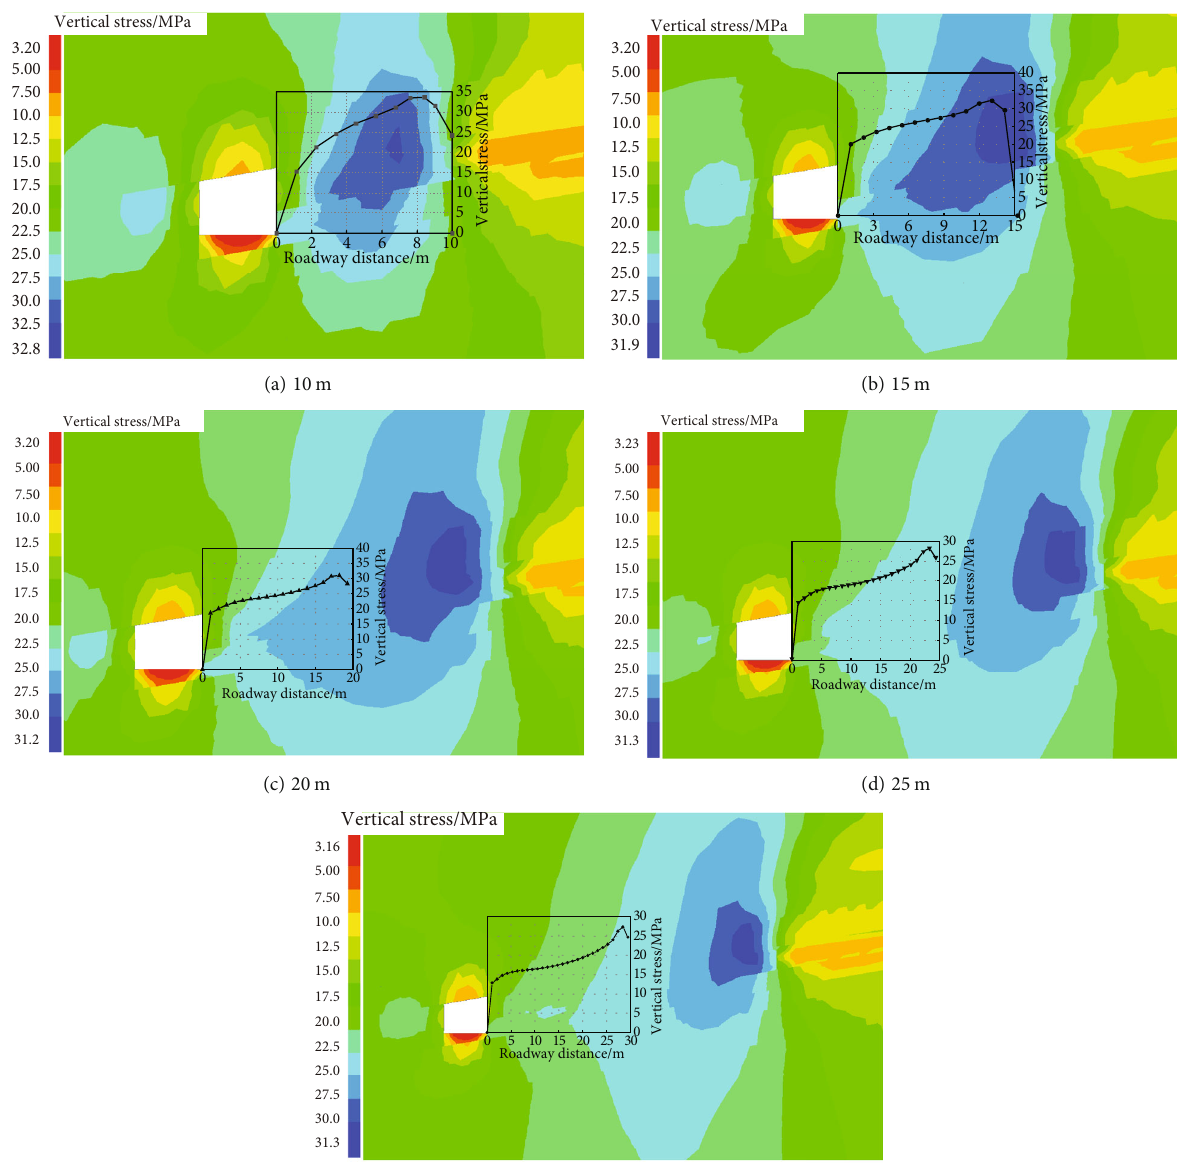
Figure 8: Vertical stress distribution in coal pillar with di ff erent